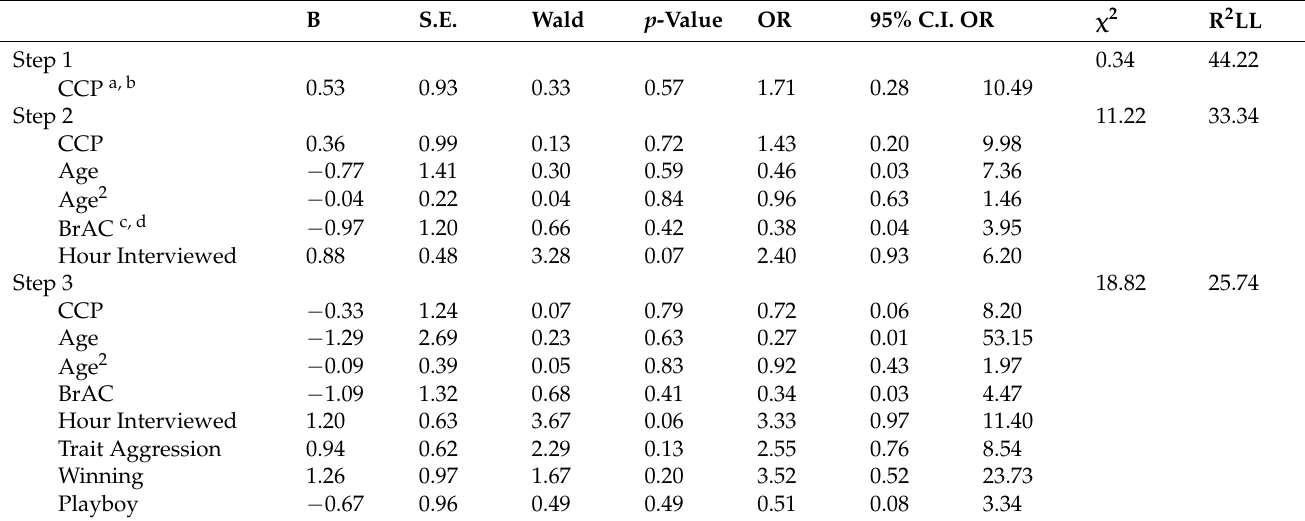
Table A4. Hierarchical Logistic Regression of UWSA for Male